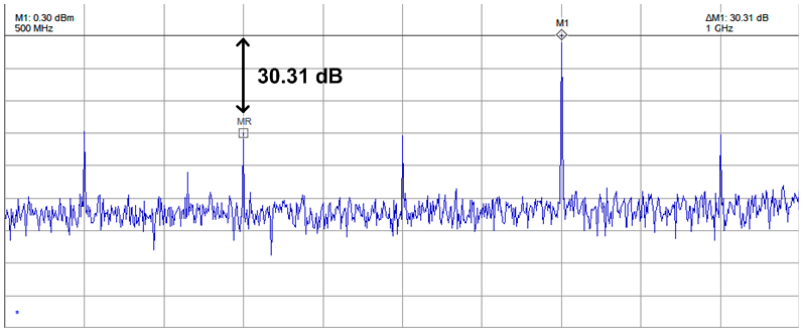
Figure 19. The measured IRR performance of the receiver.